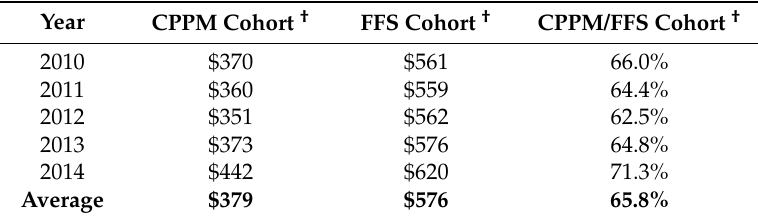
Table 4. Continuously Enrolled CPPM Members for All Five Years’ Per Member Per Month (PMPM) Costs Compared to Matched FFS Beneficiaries *.